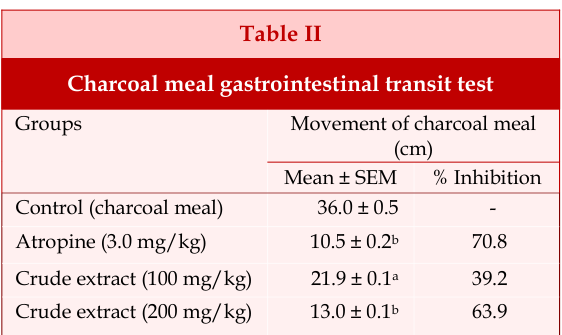
(Figure 1A). Among the fractions of C. ciliaris , dichloro- methane extract also relaxed spontaneous and K + (80 mM)-induced contraction at the tissue bath concentra- tion of 0.01-1 mg/mL with EC 50 value of 0.06 mg/mL (95% CI:0.05 to 0.09; n=5) and 1 mg/mL with EC 50 0.22 mg/mL (95% CI: 0.20 to 0.24; n=5) respectively (Figure 1B). The aqueous fraction did not show any significant relaxation of spontaneous and K + (80 mM)-induced contraction even at the highest tissue bath concentra- tion i.e. 10 mg/mL (Figure 1C). The relaxant effect of crude extract and dichloromethane extract was found similar to the effect of the standard Ca 2+ channel blocker, verapamil, which relaxed the spontaneous and K + (80 mM)-induced contractions with respective EC 50 value of 0.213 μ M (95% CI: 0.126 to 0.360; n = 4) and 0.158 μ M (95% CI: 0.123 to 0.204; n = 5) (Figure 1D). To evaluate the potential of Ca 2+ antagonistic effect, the crude and dichloromethane extracts were also tested on the control calcium concentration-response curves. The medium was made Ca 2+ free and the spontaneous contractions of the isolated jejunal preparations were eliminated completely but the addition of Ca 2+ (0.1 – 6.4